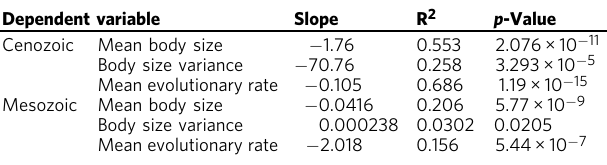
Table 2 Outputs of linear regression models comparing isotope temperature proxies with three body size